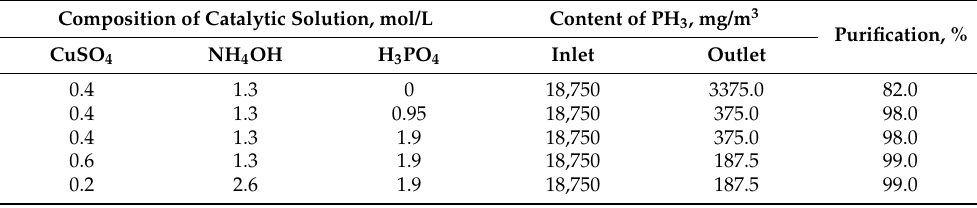
Table 5. The effect of H 3 PO 4 on the PH 3 purification efficiency at t = 50 ◦ C, V PH3 = 40 mL/min. Composition of Catalytic Solution, mol/L